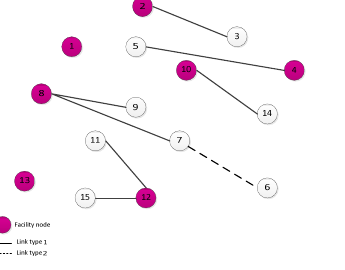
Fig. 2. The result of the base model Fig. 3. The result of two stage stochas-